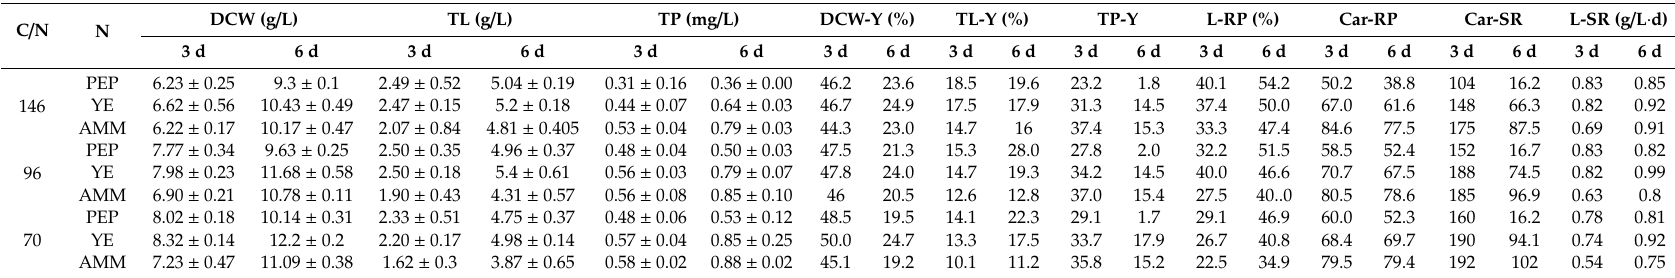
Table 3. E ff ect of di ff erent C / N ratios and di ff erent nitrogen sources on dry cell weight (DCW), lipid (TL), and carotenoid (TP) produced by R. glutinis after three and six